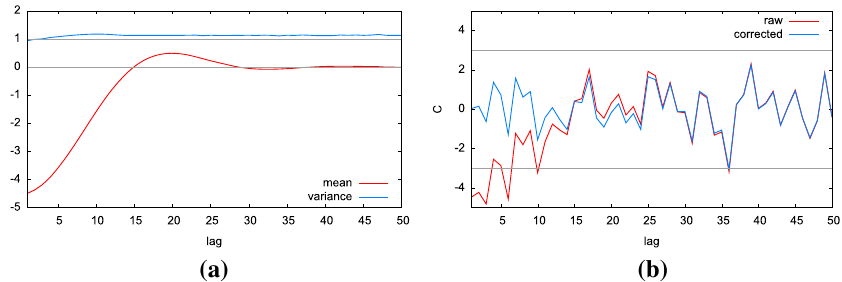
Fig. 72 Panel a shows the mean and variance of the autocorrelation for stationary, Gaussian noise caused by a Tukey window. Panel b shows the raw and corrected autocorrelation for a stationary, Gaussian noise